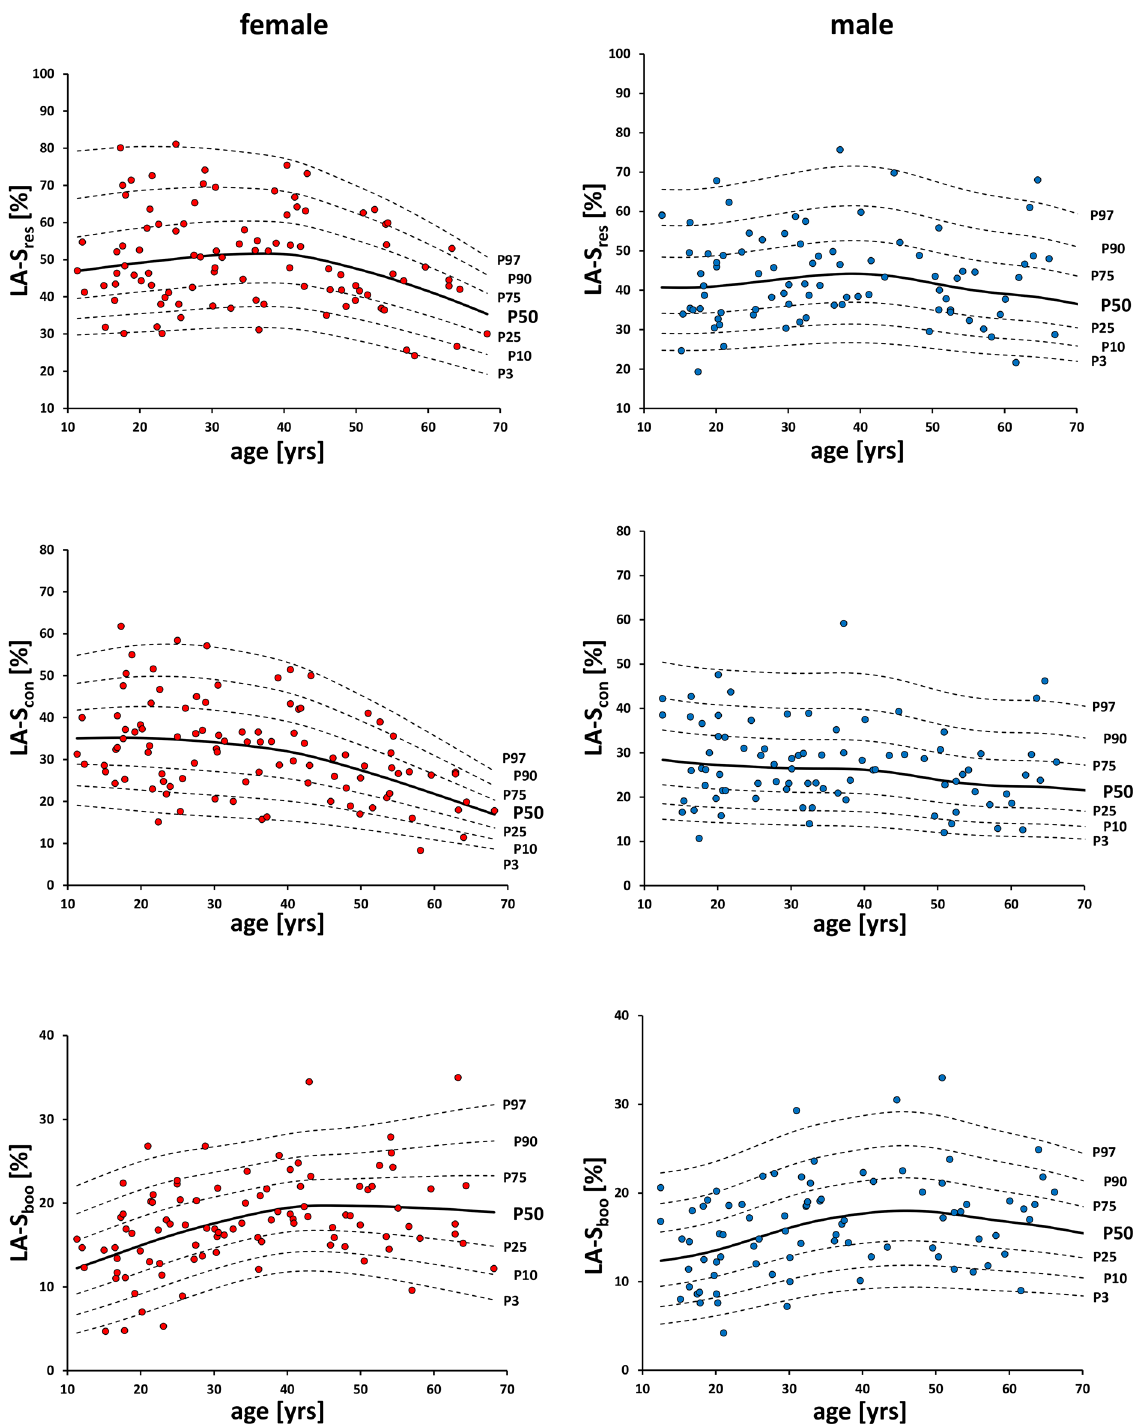
Figure 1. Gender-specific percentile curves of global longitudinal left atrial strain values by CMR feature tracking for reservoir, conduit and booster cardiac phase, respectively. LA-S res reservoir left atrial strain, LA-S con conduit left atrial strain, LA-S boo booster left atrial